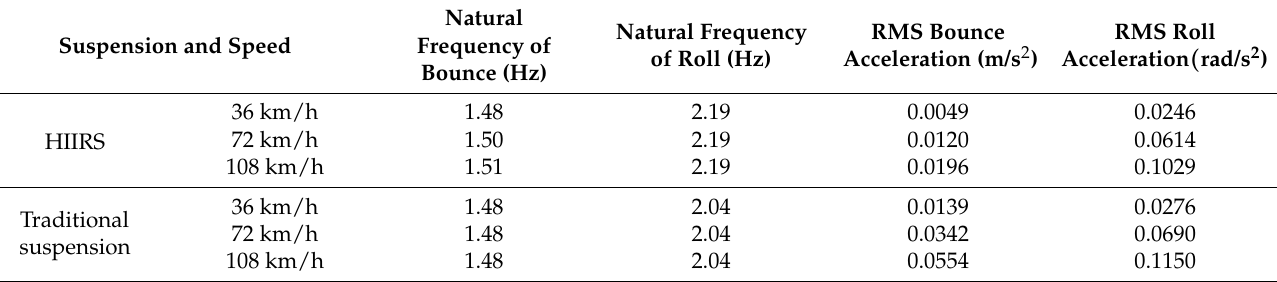
Figure 9 compared the power spectrum density of bounce/roll acceleration between the HIIRS-equipped vehicle and the traditional vehicle, when the vehicles are driven on a Class-B road (c = 64 × 10 − 8 ) . In the traditional vehicle, the stiffness and damping are, respectively, 80000 and 4400 Ns/m. The corresponding results are also summarized in Table 6. Table 6. The comparison of the natural frequency and RMS bounce/roll acceleration between the HIIRS system and traditional suspension